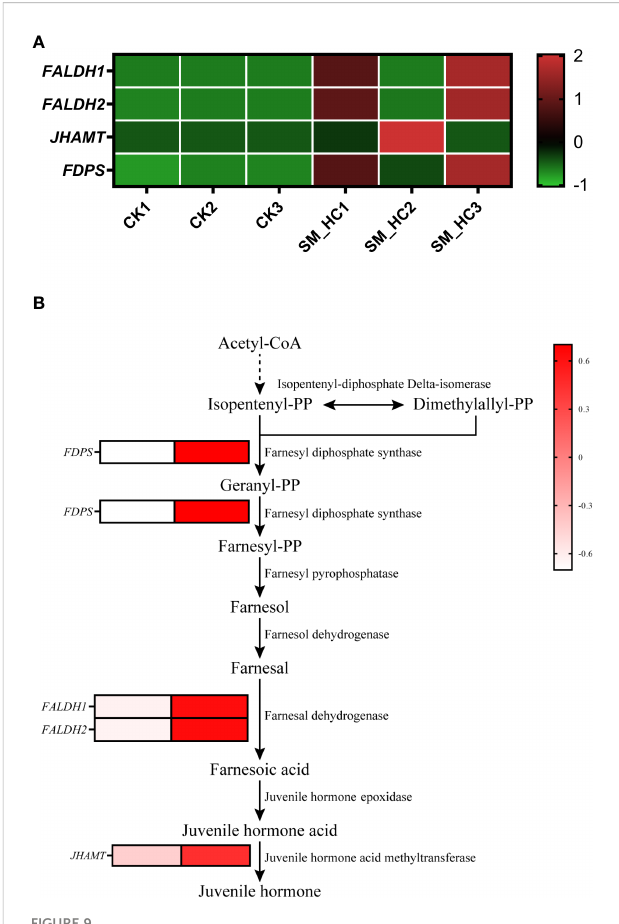
FIGURE 9 Changes in JH synthesis in H cunea infected by SM1. (A) Heatmap analysis of upregulation genes in JH synthesis using transcriptome data. The control groups were labeled as CK1, CK2 and CK3. H cunea groups infected with SM1 were labeled as SM_HC1, SM_HC2 and SM_HC3. (B) Diagram of genes related to JH synthesis in H cunea infected by